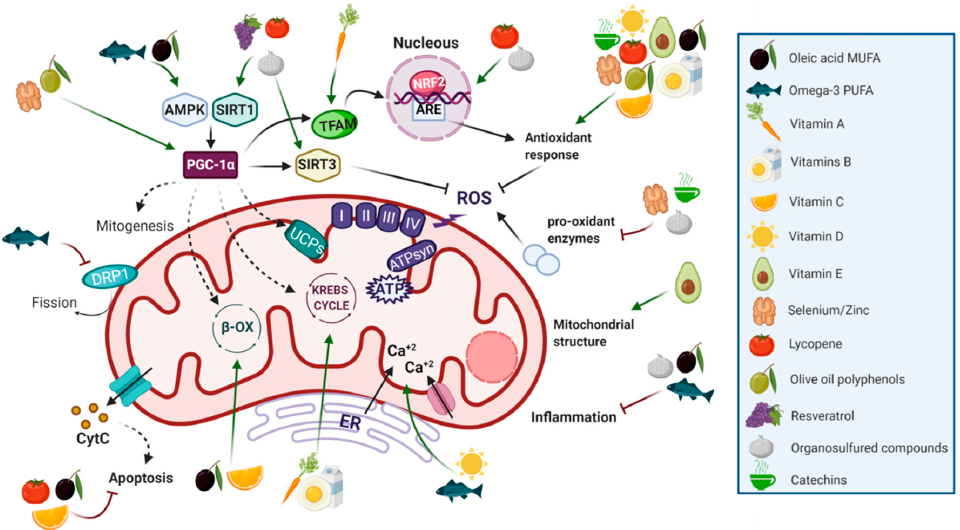
Figure 3. Principal nutrients with beneficial effects on mitochondrial function. Oleic acid, omega-3,